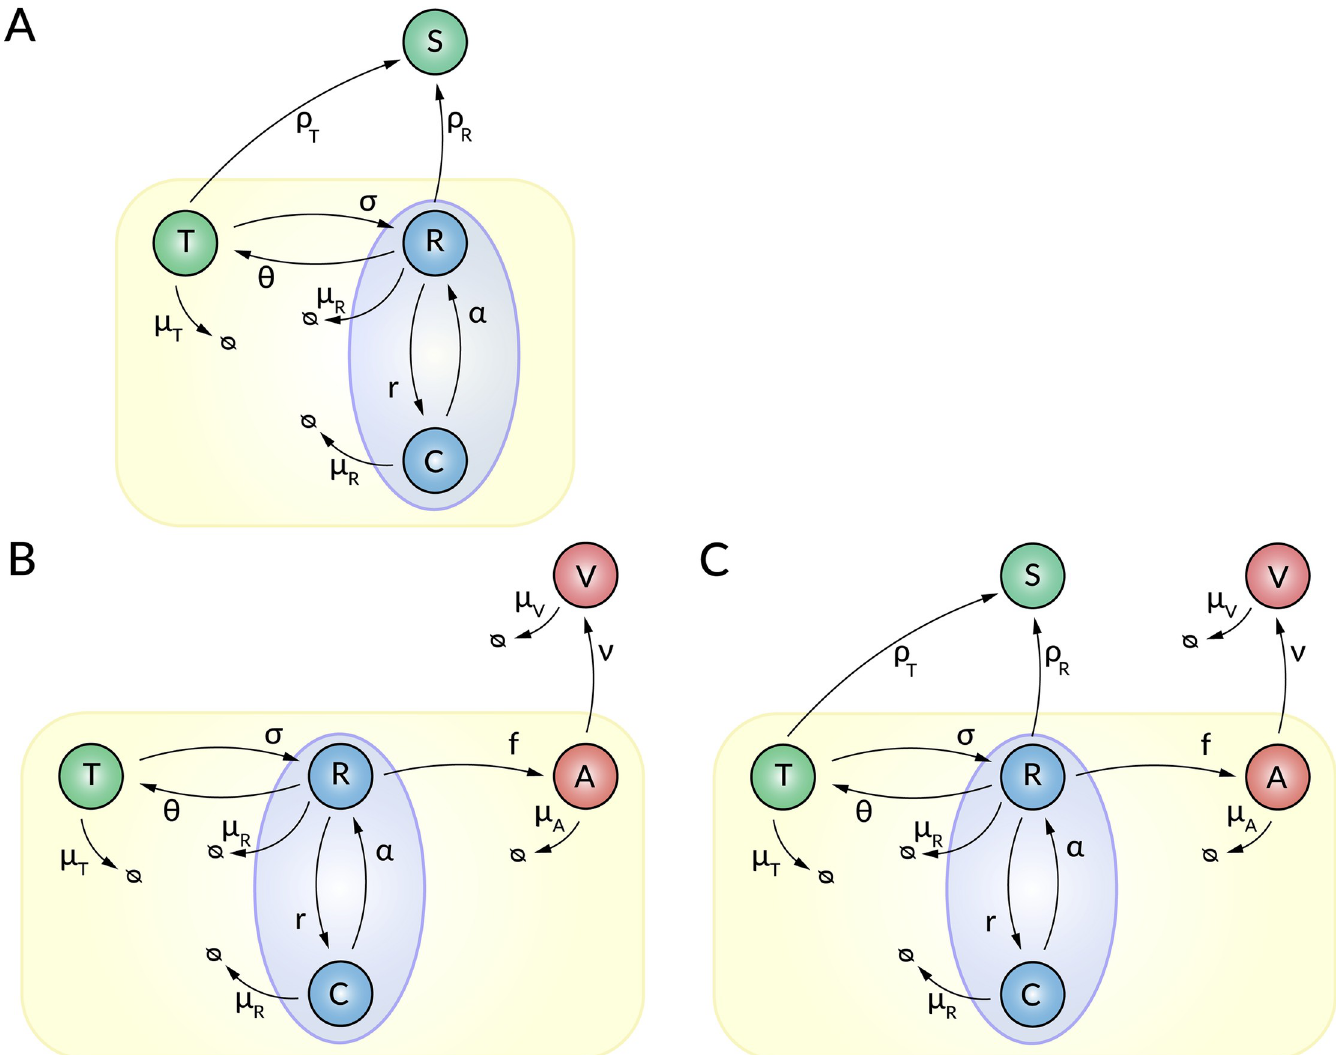
Fig 1. Schematic illustration of the intracellular HCV replication models. ( A ) The hepatitis C RNA secretion model (SM), ( B ) the replication model extended by virus assembly and release without considering RNA secretion (AM), and ( C ) the combined model (CM) accounting for secretion and virus release. Intracellular HCV replication is initiated by plus-strand RNA that is translated ( T ) and transferred into the replication compartment (RC) at rate σ . Within the RC, the plus-strand RNA ( R ) is used to synthesize minus-strand RNA ( C ) at maximum rate r , which in turn is used for plus-strand RNA synthesis at rate α . Plus-strand RNA located at the site of translation ( T ) and/or in proximity to the RC ( R ) may be secreted as HCV RNA containing particles ( S ) at rate ρ and/or ρ , respectively. Newly synthesized plus-strand T R RNA ( R ) may be transferred to sites of viral assembly ( A ) at rate f . HCV particles ( V ) are released from the cell at rate v and degrade with rate μ V . Intracellular RNA in the cytoplasm ( T ) degrades with rate μ , while RNA species ( R and C ) within the RC degrade with rate μ T R